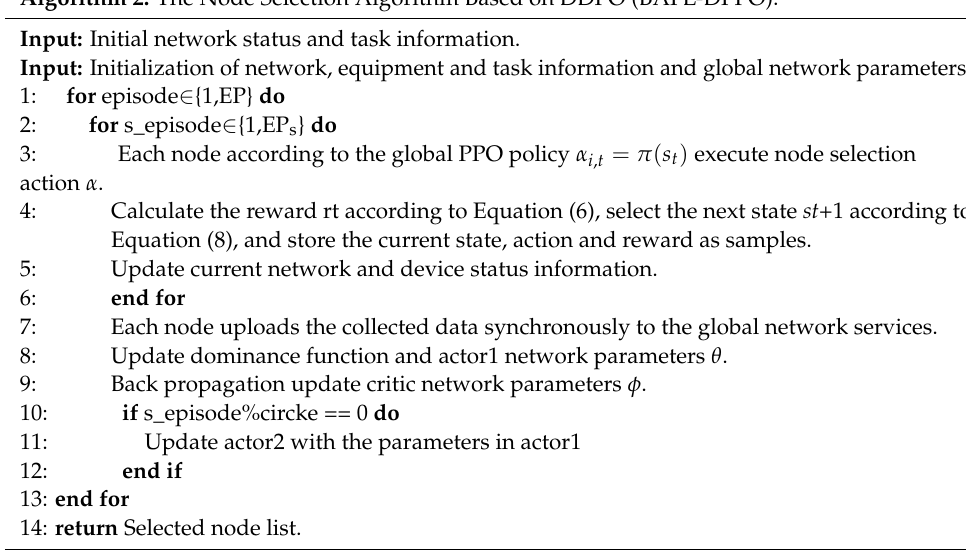
Algorithm 2: The Node Selection Algorithm Based on DDPO (BAFL-DPPO). Input: Initial network status and task